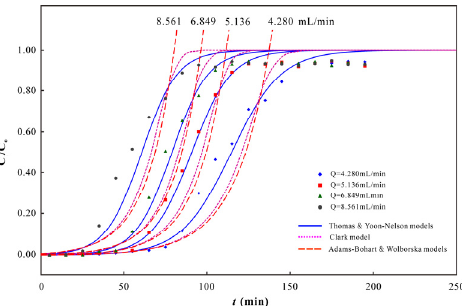
Figure 5. Effect of influent concentration on breakthrough curve of PC ‐ Fe/C ‐ B adsorption As(V).